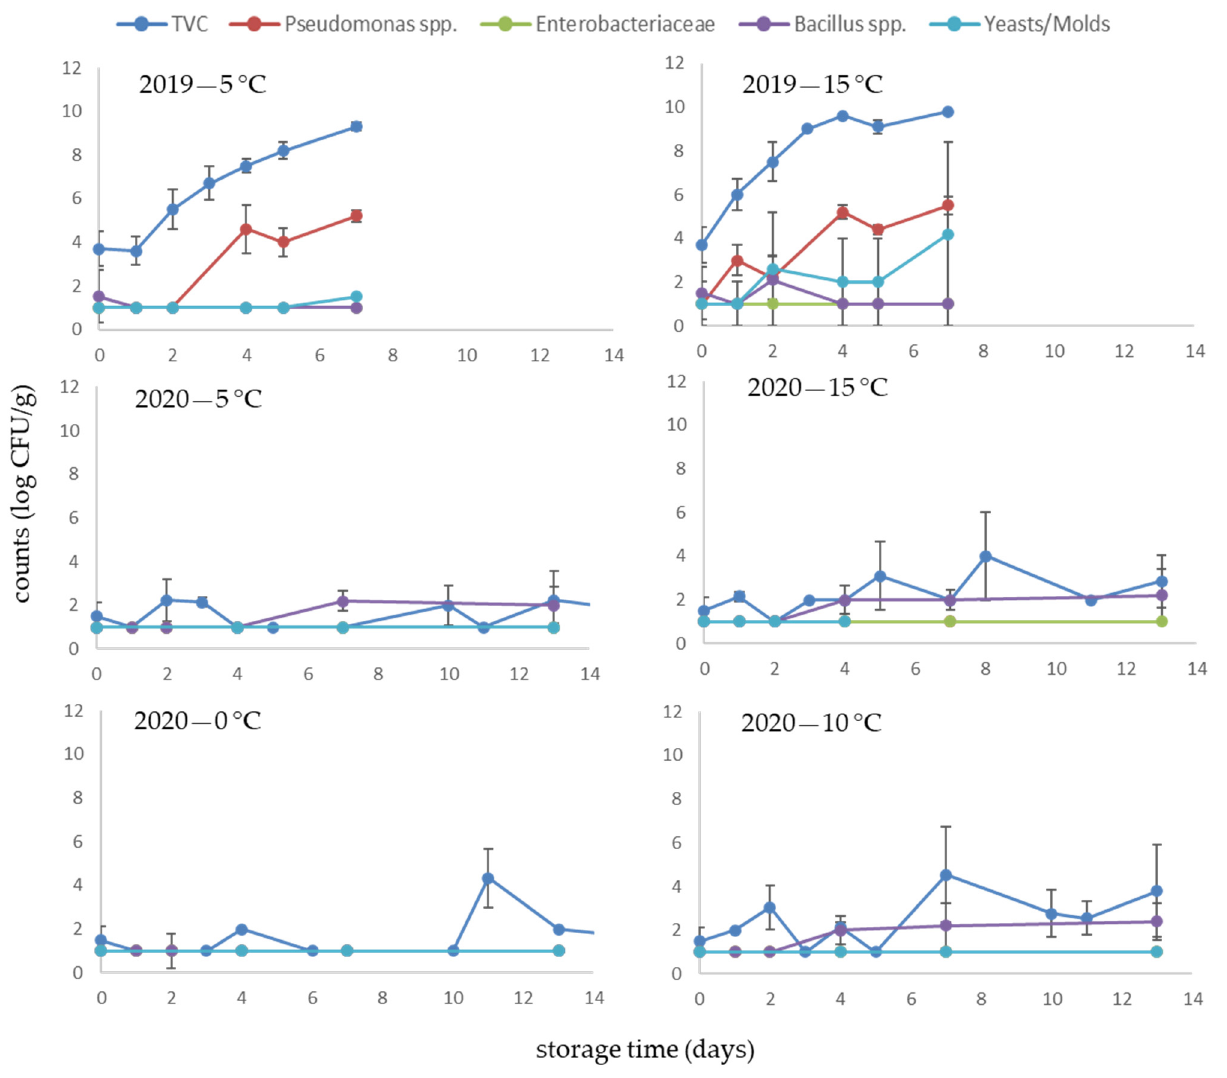
Figure 2. Changes in the microbial counts of S. latissima stored aerobically at 5 and 15 °C (year 2019) and 0, 5, 10 and 15 °C (year 2020).